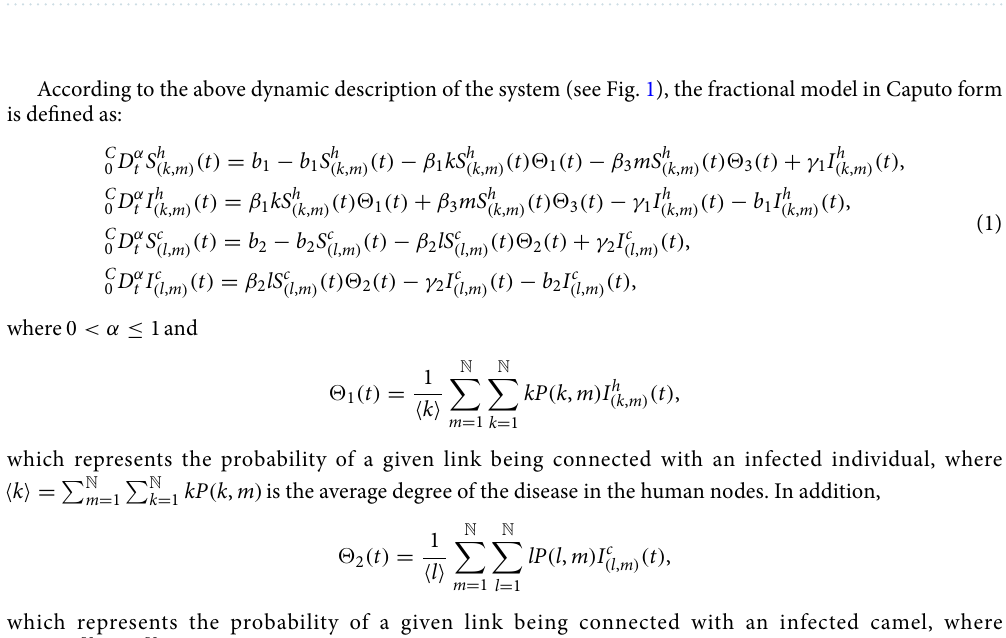
Table 1. Parameter